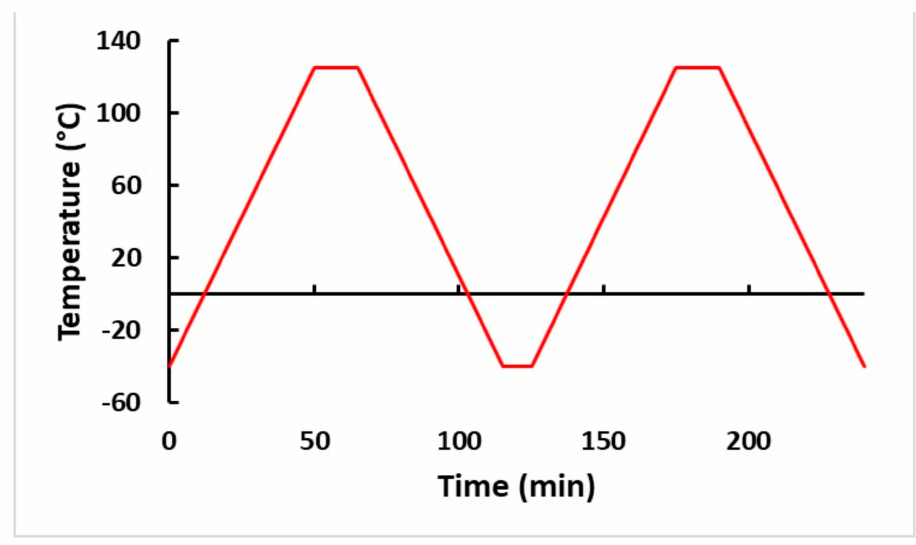
Figure 4. Thermal cycling